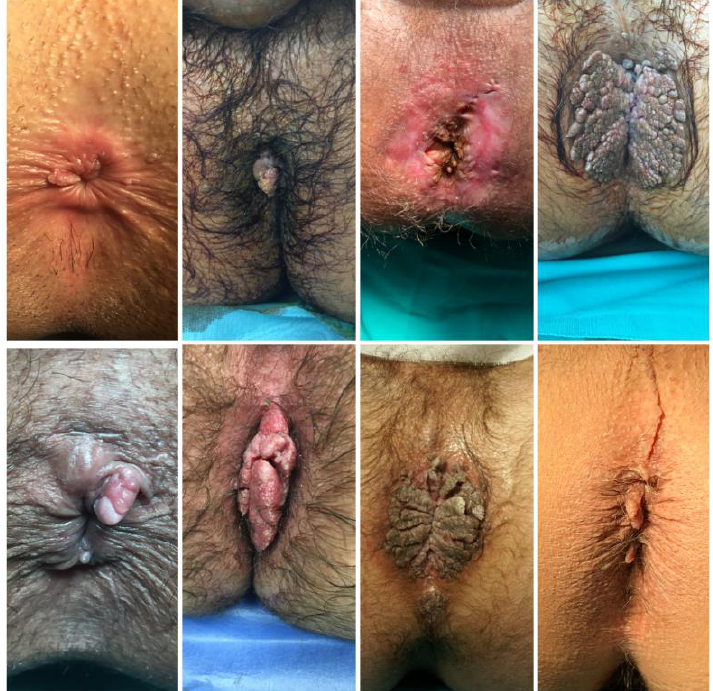
Figure 1. Different typical clinical presentation of CA as single papules or cauliflower-like plaques.